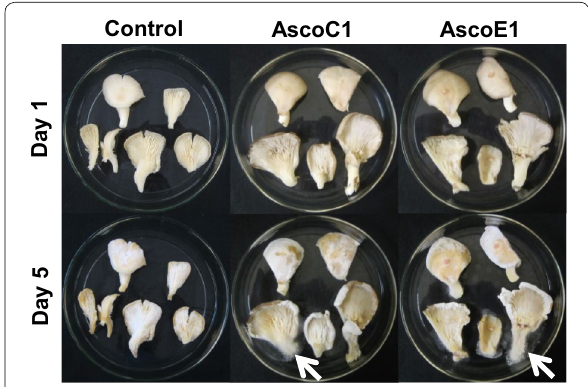
Fig. 7 Infection test with commercial P. ostreatus fruiting bodies. Top: day of inoculation, bottom: mushrooms after 5 days of cultivation at RT. Arrows mark infested stipe regions. Other mycelial outgrowth noticed came from P. ostreatus